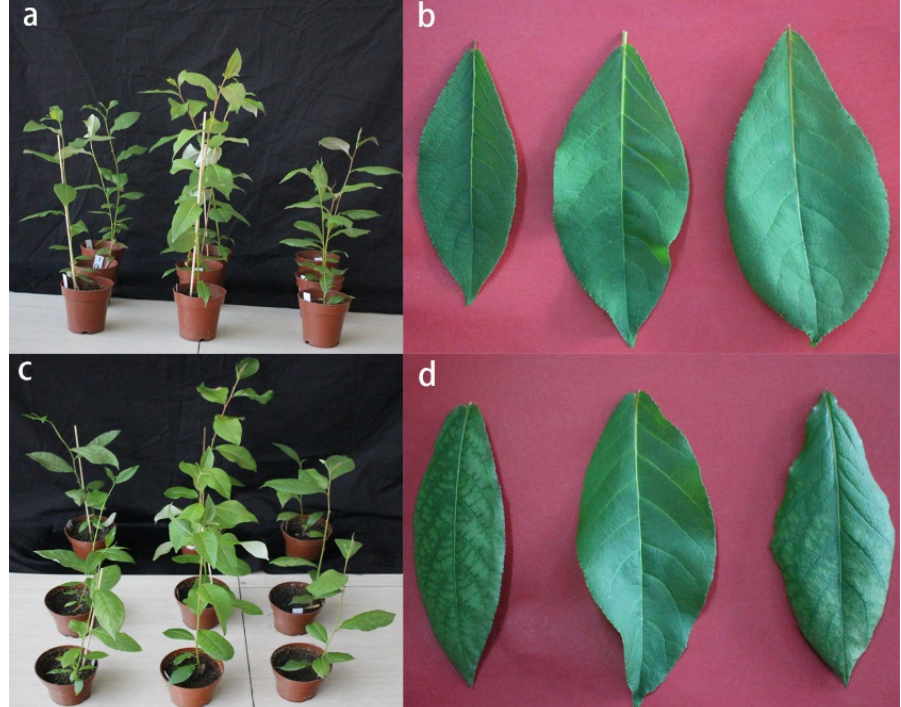
Figure 1. Morphological observation on CK, T12, and F20 plants and functional leaves before and 10 days after salt stress. ( a ) The plants from left to right indicate CK, T12, and F20 plants under normal growth conditions (i.e., before salt stress). ( b ) The leaves from left to right indicate the fifth functional leaves of CK, T12, and F20 under normal growth conditions (i.e., before salt stress). ( c ) The plants from left to right indicate CK, T12, and F20 plants 10 days after salt stress. ( d ) The leaves from left to right indicate the fifth functional leaves of CK, T12, and F20 10 days after salt stress. Morphological observation of the CK, T12, and F20 plants indicated that three clones all exhibited salt injury symptoms 10 days after salt stress (Figure 1c). A close-up view of the fifth functional leaves of three clones showed the salt injury spots spread over the whole fifth leaf of CK; the fifth functional leaf of T12 did not exhibit significant salt injury; and half of the fifth leaf of F20 contained salt injury spots (Figure 1d). Leaf salt injury index analysis indicated there were significant injury level difference among CK, T12, and F20. CK suffered the most severe salt injury (12 d after salt stress, 50.93 ± 3.57%; 15 d after salt stress, 57.81 ± 3.09%); T12 suffered the most slight salt injury (12 d after salt stress, 24.69 ± 2.36%; 15 d after salt stress, 35.10 ± 3.37%); and F20 suffered medium salt injury (12 d after salt stress, 45.37 ± 3.19%; 15 d after salt stress, 50.94 ± 3.54%) (Figure